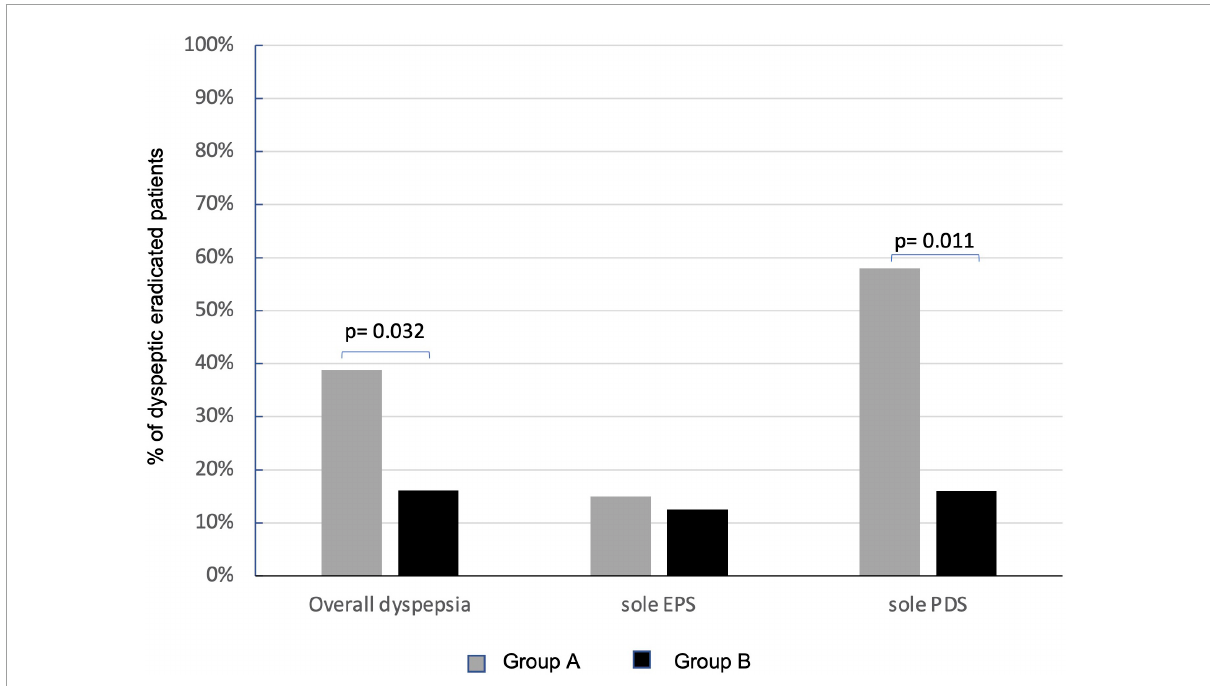
FIGURE4 Effects of Lactobacillus rhamnosus GG (LGG) supplementation in improving overall dyspepsia and relative subtypes. Persistence of dyspepsia at PP analysis in group A (sole BQT treatment and gray columns) and group B (BQT treatment with LGG supplementation and black columns). EPS, epigastric pain syndrome; PDS, postprandial distress